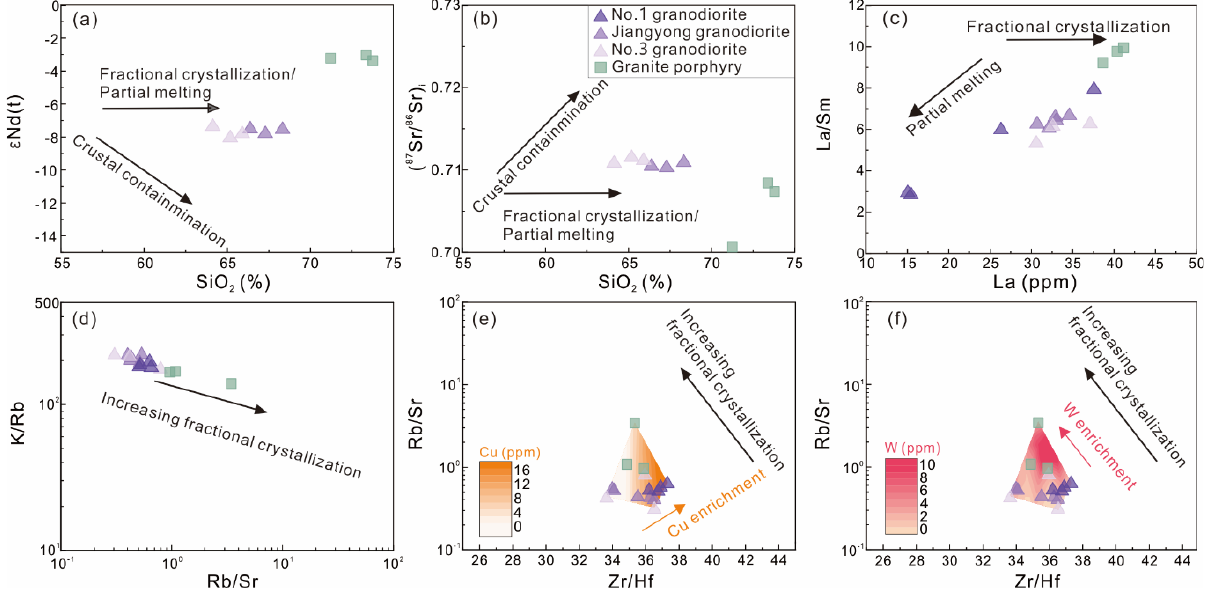
Figure 11. Plots of ( a ) SiO 2 vs. εNd(t), ( b ) SiO 2 vs. ( 87 Sr/ 86 Sr) i , ( c ) La vs. La/Sm, ( d ) Rb/Sr vs. K/Rb, ( e ), Zr/Hf vs. Rb/Sr with contour map of Cu concentrations, ( f ) Zr/Hf vs. Rb/Sr with contour map of W concentrations.